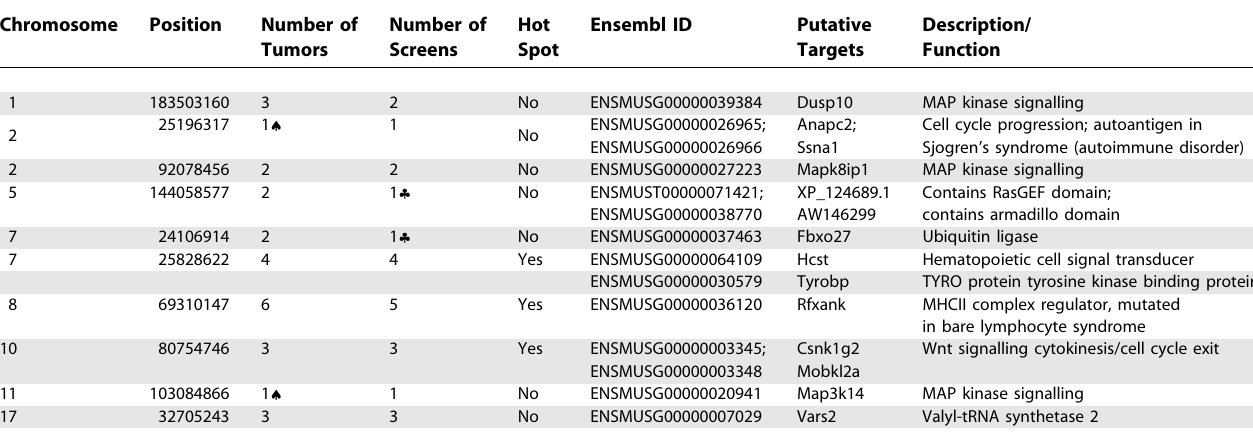
Table 1: Overview of the Novel CISs Detected by GKC Chromosome Position Number of